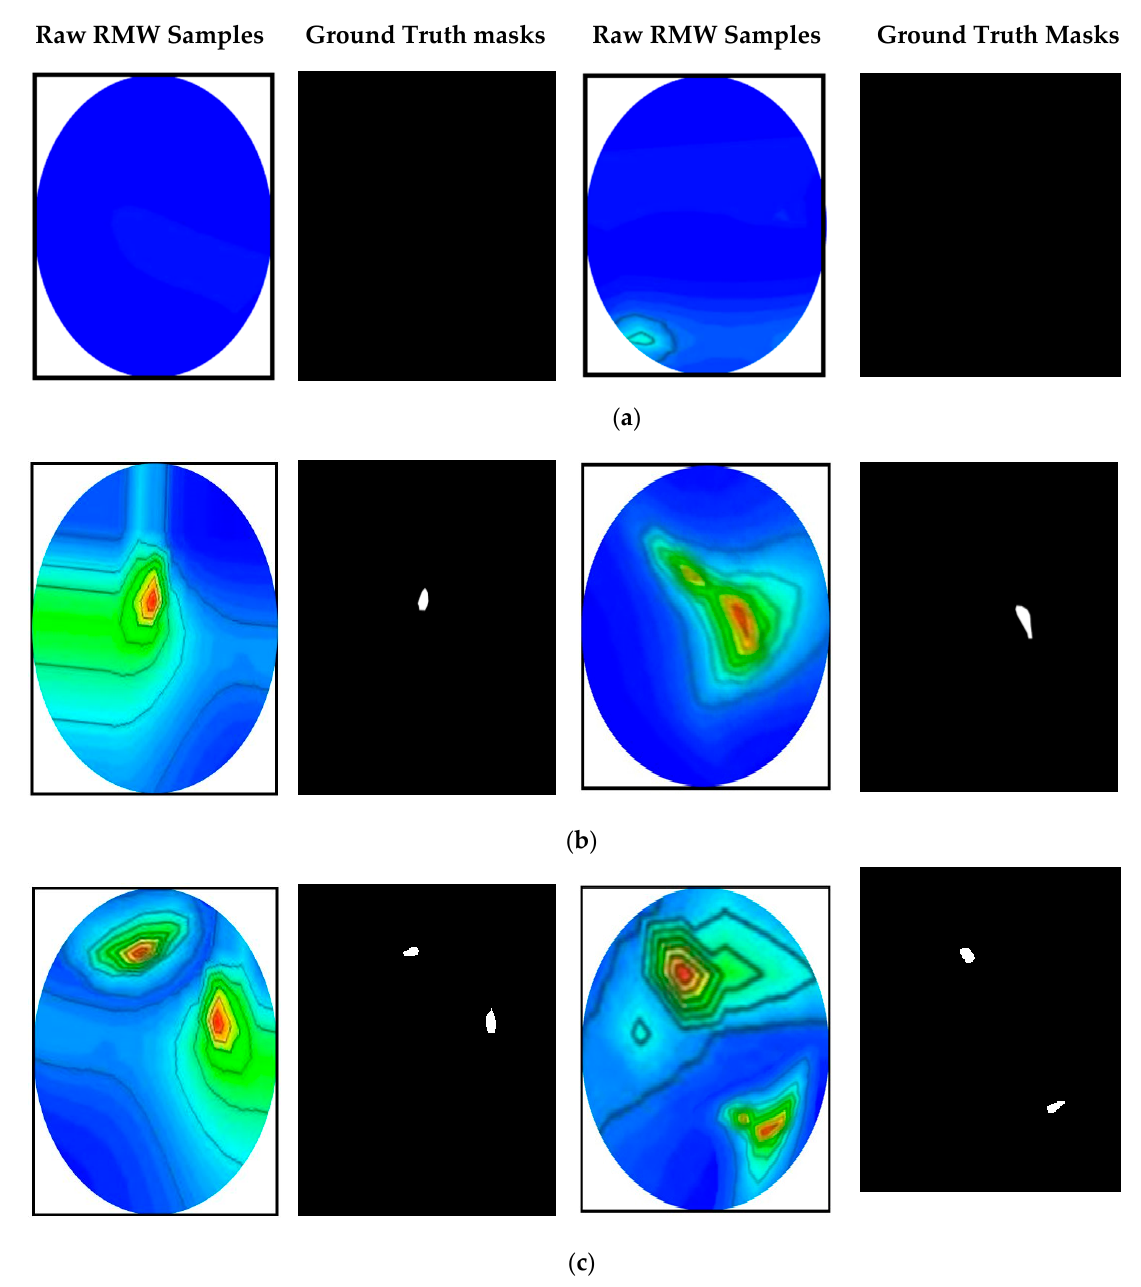
Figure 9. The RMW brain image samples and their corresponding ground truth masks from the original dataset: ( a ) non-tumor, ( b ) single tumor, and ( c ) double tumors. original dataset: ( a ) non-tumor, ( b ) single tumor, ( c ) double